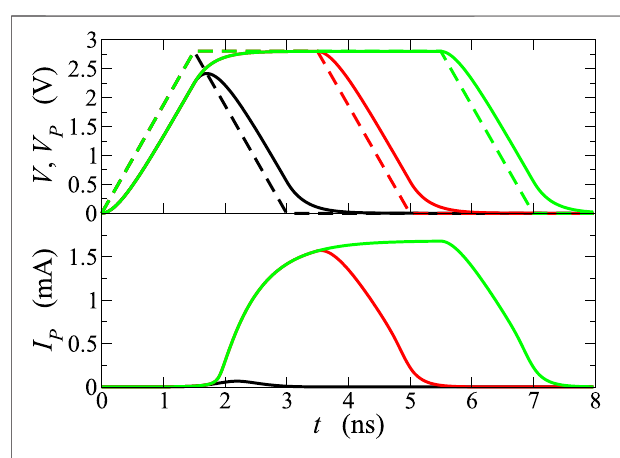
FIGURE10| Sameasin Figure9 ,withdifferentdurationsoftheplateau of V ; the latter is set at 2.8 V, and capacitance C is set at 300 pF.